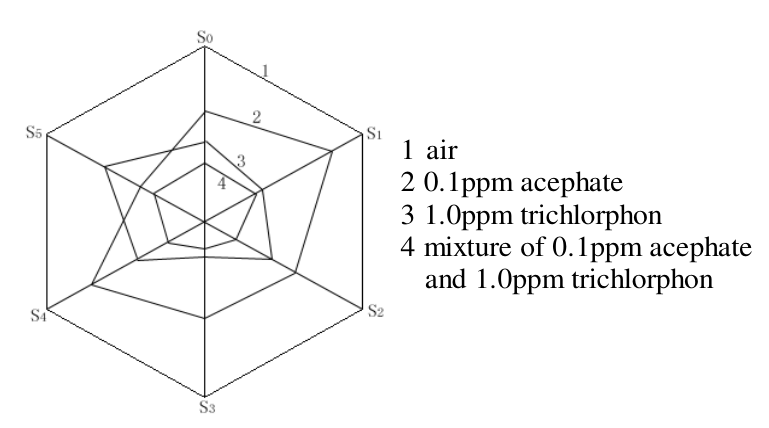
Figure 8. Polar plots of the 0.1ppm acephate, 1.0ppm trichlorphon and mixture of 0.1ppm acephate and 1.0ppm trichlorphon gas.